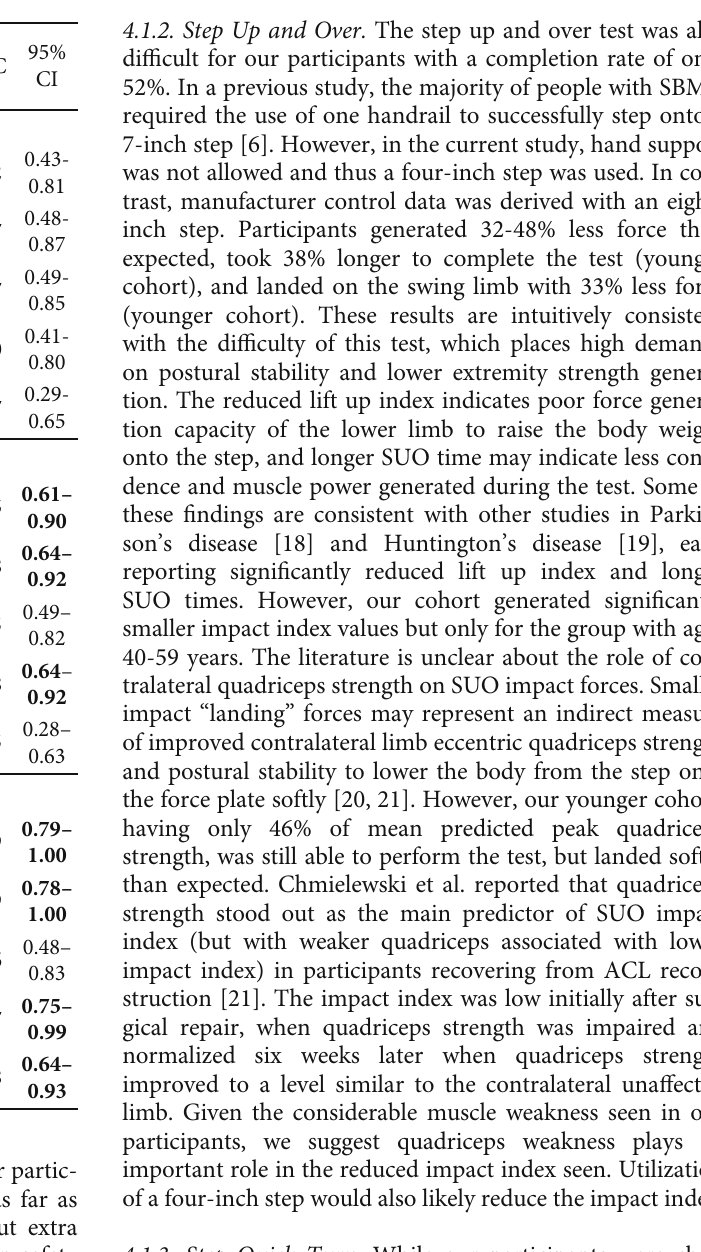
Table 2: Muscle strength as a discriminator between those in the SBMA cohort who were able versus those who were not able to complete each balance test. Strength values are expressed as a percentage of predicted. For clarity, only the right side is presented except for averaged composite strength (lower